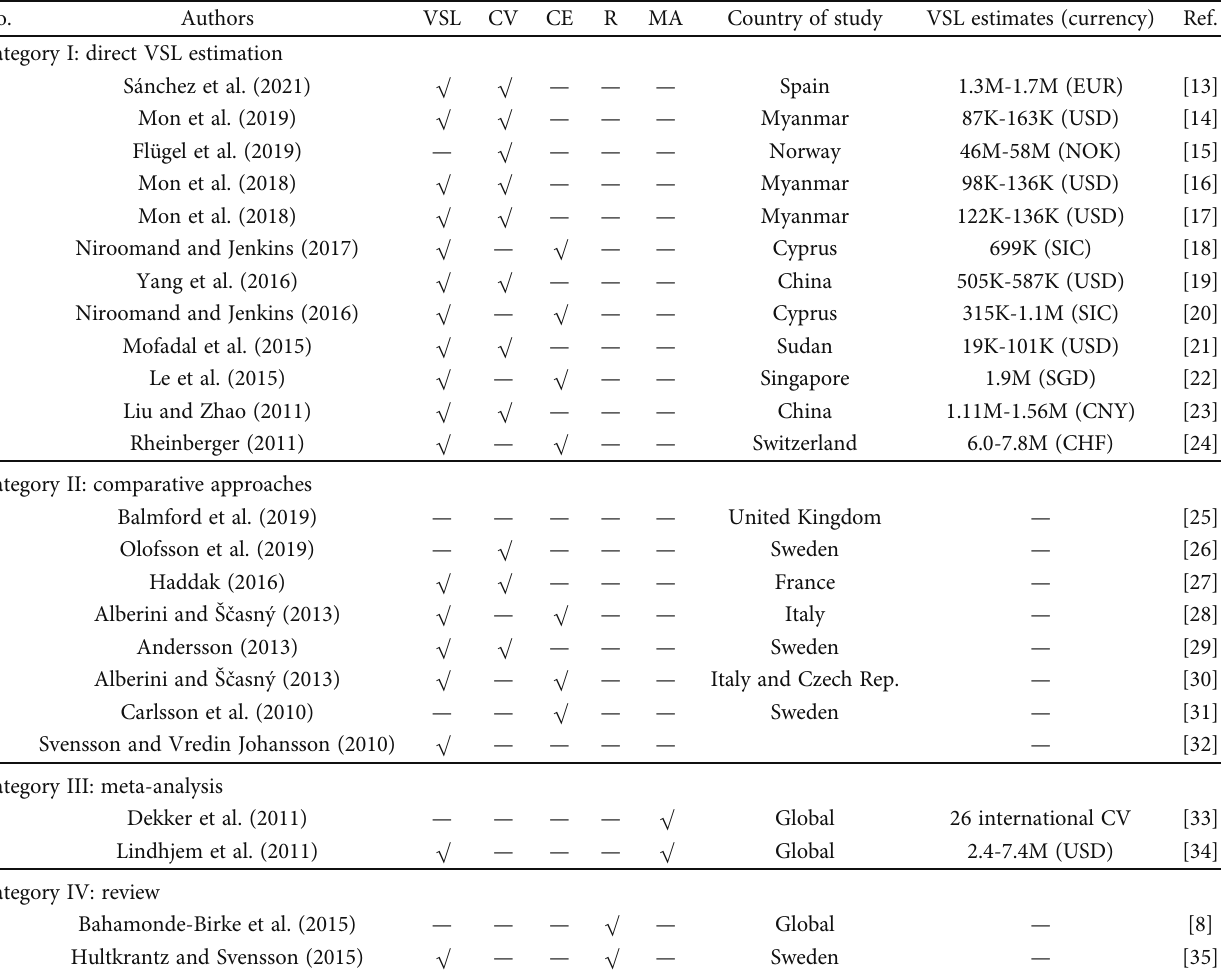
Table 1: Summary of literature in descending chronological order (source: